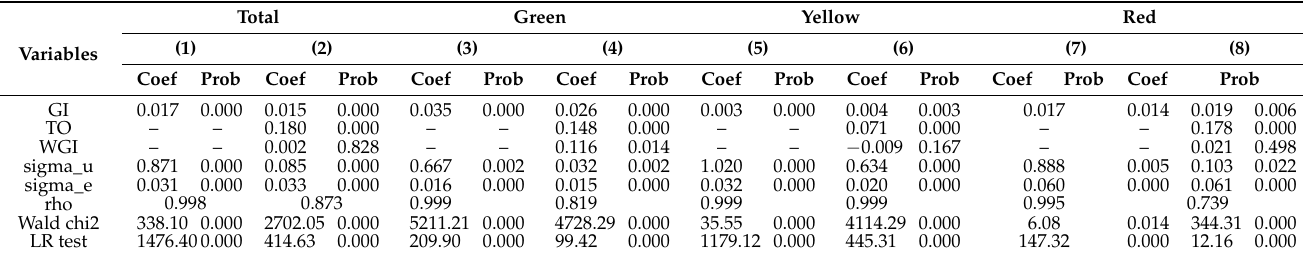
Table 5. The findings of the Tobit model within the countries’